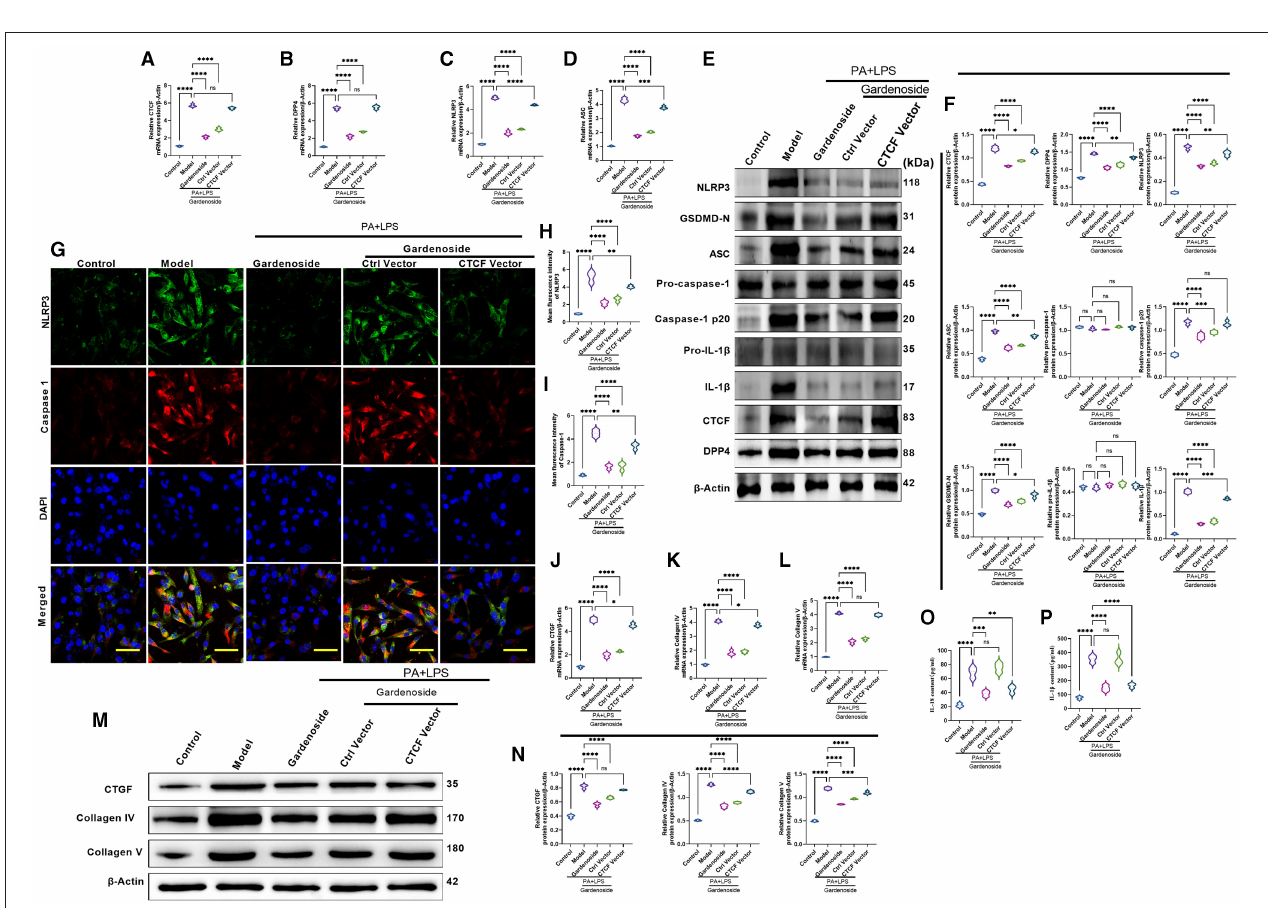
FIGURE 6 | CTCF overexpression counteracted the effect of gardenoside on the activation of the NLRP3 inflammasome, caspase-1-induced pyroptosis and fibrosis pathways in hepatocytes. (A) RT-qPCR detection of the relative mRNA expression of CTCF in AML cells in indicated groups. (B) RT-PCR detection of the relative mRNA expression of DPP4 in AML cells in indicated groups. (C) RT-PCR detection of the relative mRNA expression of NLRP3 in AML cells in indicated groups. (D) RT-PCR detection of the relative mRNA expression of ASC in AML cells in indicated groups. (E) Representative bands of Western blot detection of the relative protein expression of CTCF, DPP4, NLRP3, ASC pro-caspase-1 p20, caspase-1 p20, GSDMD-N, pro-IL-1 β , and IL-1 β in AML cells in indicated groups. (F) Densitometry analysis of bands of Western blot detection of the relative protein expression of CTCF, DPP4, NLRP3, ASC pro-caspase-1 p20, caspase-1 p20, GSDMD-N, pro-IL-1 β , and IL-1 β in AML cells in indicated groups. (G) Representative images of immunofluorescence analysis of NLRP3 and Caspase-1 expression in AML cells in indicated groups (scale bar: 50 µ m). (H) Quantification of immunofluorescence intensity of NLRP3 expression in different groups as determined by immunofluorescence analysis. (I) Quantification of immunofluorescence intensity of Caspase-1 expression in different groups as determined by immunofluorescence analysis. (J) RT-qPCR detection of the relative mRNA expression of the fibrosis marker CTGF in AML cells in indicated groups. (K) RT-qPCR detection of the relative mRNA expression of the fibrosis marker Collagen IV in AML cells in indicated groups. (L) RT-qPCR detection of the relative mRNA expression of the fibrosis marker Collagen V in AML cells in indicated groups. (M) Bands of Western blot detection of the relative protein expression of the fibrosis markers CTGF, Collagen IV, and Collagen V in AML cells in indicated groups. (N) Densitometry analysis of bands of Western blot detection of the relative protein expression of the fibrosis markers CTGF, Collagen IV, and Collagen V in AML cells in indicated groups. (O) ELISA detection of the protein level of IL-18 in indicated groups. (P) ELISA detection of the protein level of IL-1 β in indicated groups. ns, non-significant, * p < 0.05, ** p < 0.01, *** p < 0.001, and **** p < 0.0001 in the comparison between the indicated